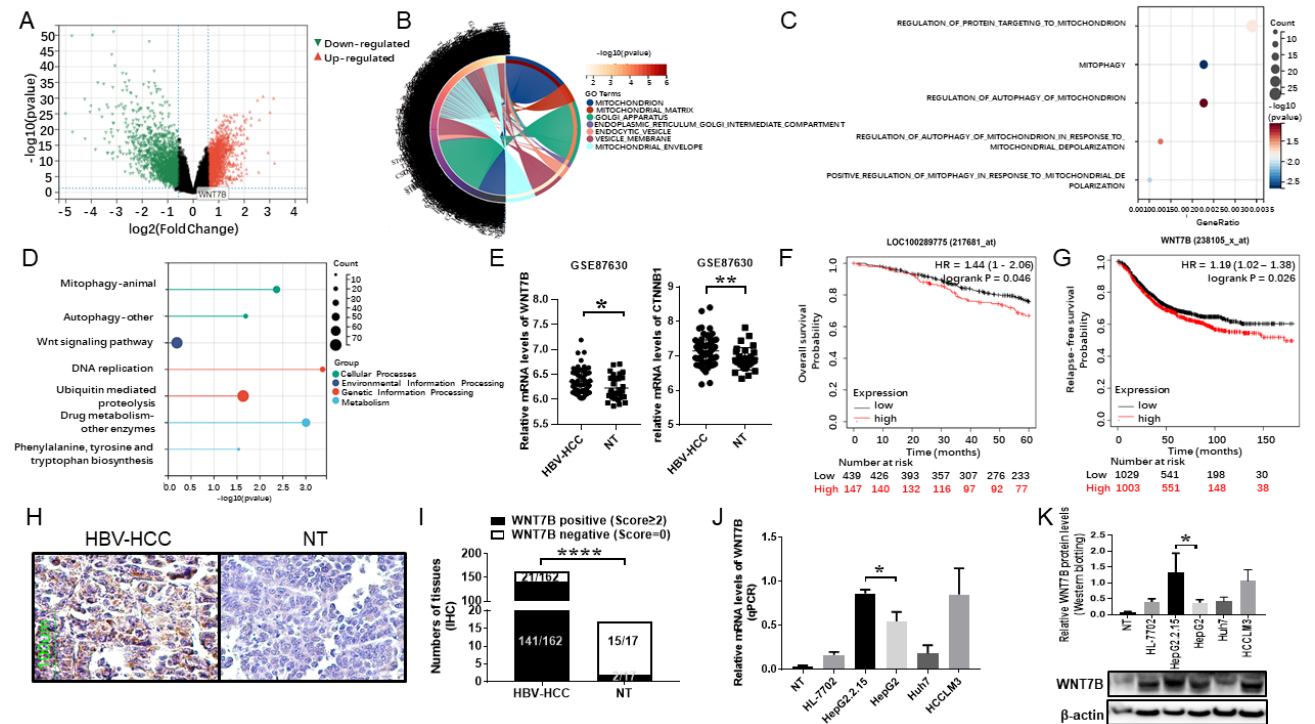
Figure 1. WNT7B is abundantly expressed in HBV-associated HCC and predicts a poor prognosis according to bioinformatics and clinical tissues. ( A ) The volcano plot of each gene expression profile datum was created using R software, and 9863 differentially expressed genes were discovered. ( B , C ) Gene Ontology (GO) analysis was performed on the differentially expressed genes based on subcellular components ( B ) and biological processes ( C ). ( D ) KEGG categorization of the differentially expressed genes in GSE87630. ( E ) The WNT7B and CTNNB1 levels in GSE87630 were determined. * p < 0.05, ** p < 0.005 ( F , G ) The Kaplan–Meier survival analysis of WNT7B expression and overall survival (OS) in grade 3 HCC patients ( F ) and relapse-free survival (RFS) in HCC patients ( G ) using the Kaplan–Meier Plotter. ( H , I ) WNT7B staining in HBV-associated HCC and nontumorous liver tissues (NTs) using immunohistochemistry. The photographs are representative (scale bar, 100 μ m). The graph depicts the ratio of positive to negative WNT7B numbers in HCC and NTs. **** p < 0.0001 ( J , K ) WNT7B expression was measured in four HCC cell lines using qPCR ( J ) and Western blotting ( K ). The graphs show the mean ± SD of at least three independent experiments. * p < 0.05.